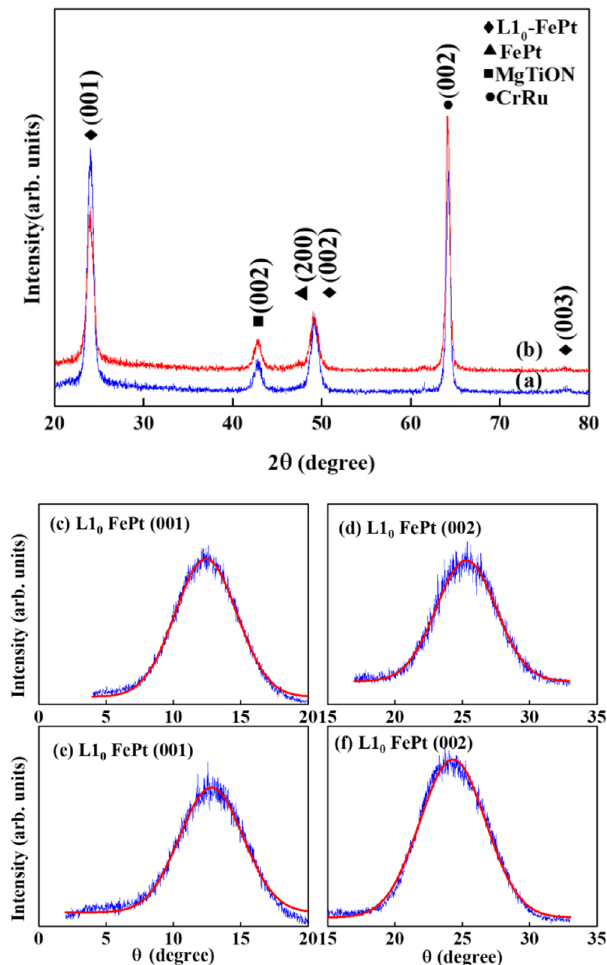
Figure 1. XRD patterns and rocking curves of FePt(B, Ag, C)( x )/MoC/MgTiON/CrRu films, x = ( a ) 8 nm, ( b ) 6 nm, ( c , d ) 8 nm, ( e , f ) 6 nm. The lattice misfit between FePt/MgTiON is 9%, and the FePt film is under tensile stress during ordering and grain growth. The FePt ordering degree is proportional to the [I(001)/I(002)] 1/2 ratio; here I(001) and I(002) are the integrated intensities of the FePt (001) and (002) diffraction peaks, and the ratio is 2.99 (the ordering values estimated from [(I (001) /I (002) )/(I* (001) /I* (002) )] 1/2 are 0.89 [22,23] and 2.87, respectively, shown in Figure 1). The rocking curve was measured to evaluate the c-axis alignment of the FePt grains and